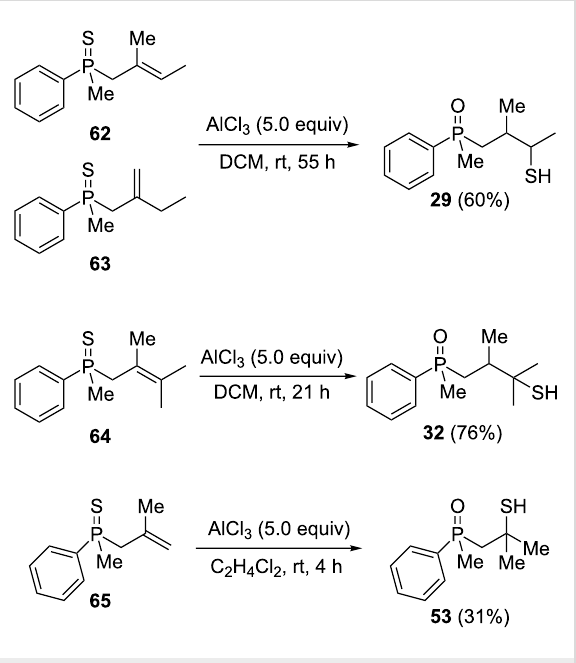
Scheme 8: The reaction of alkenylphosphine sulfides with AlCl 3